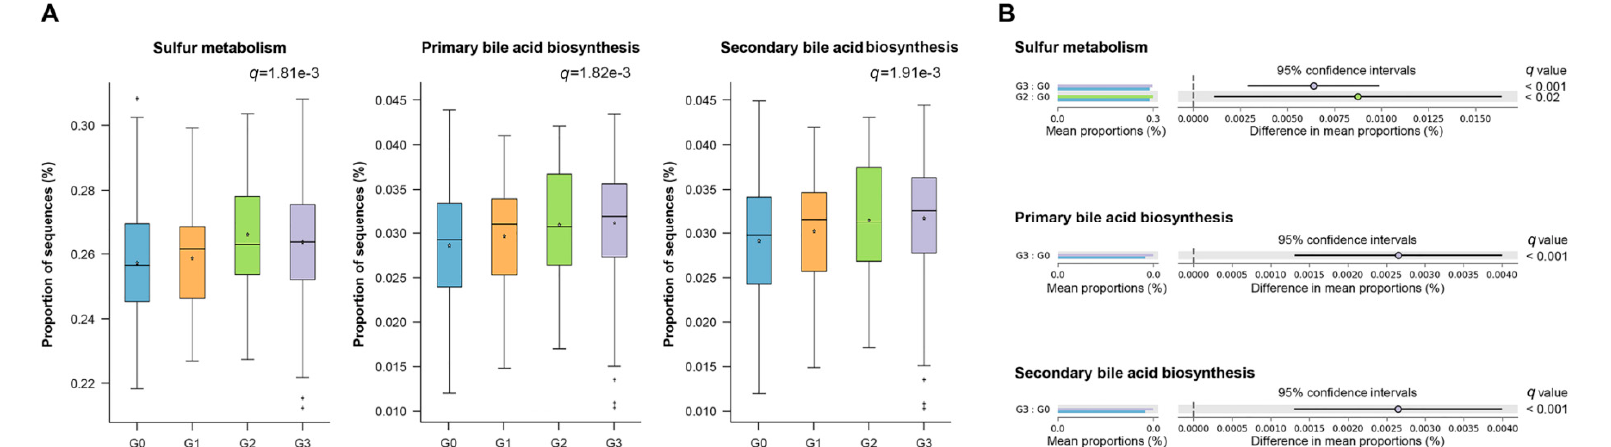
Figure 5. Prediction of metagenome functional content correlated with fatty liver using Phylogenetic Investigation of Communities by Reconstruction of Unobserved States (PICRUSt). ( A ) Box plot showing the distribution in the proportion of specific pathways assigned to samples from the four groups. Boxes indicate the interquartile range (IQR). The IQR is the 25th to 75th percentile. The median value is shown as a line within the box and the mean value is shown as an asterisk. Whiskers extend to the most extreme value within 1.5 × IQR. Possible outliers are shown as crosses. ( B ) Post hoc plot for each pathway indicating the difference in mean proportions for each pair of groups. The box plot ( A ) and extended error bar plot ( B ) indicate Kyoto Encyclopedia of Genes and Genomes (KEGG) pathways where two-sided Welch’s t -test produced a q < 05, adjusted using the Bonferroni method.